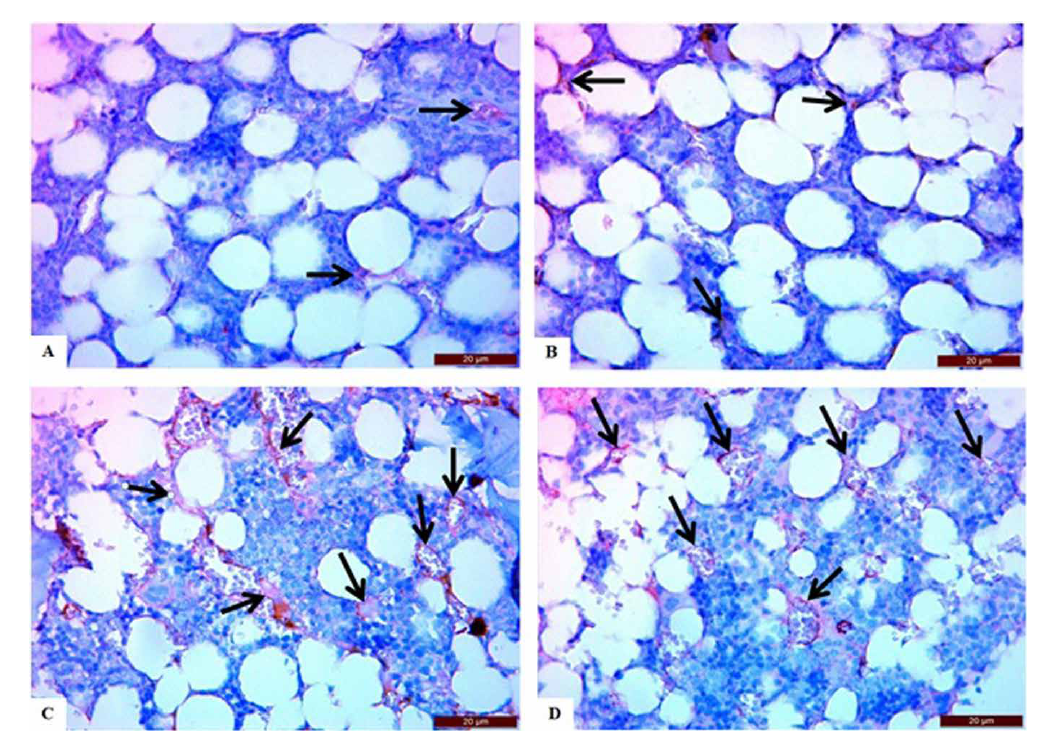
FIGURE 2 – Images showing vessel formation (angiogenesis) in the right femur bone marrow of rats with ovariectomy-induced osteoporosis. A: Control group, B: OVX group, C: OVX+zaprinast group and D: OVX+avanafil group. Red-pink staining shows the formation of new vascular structures in the sections. Scale bar: 20 µm.